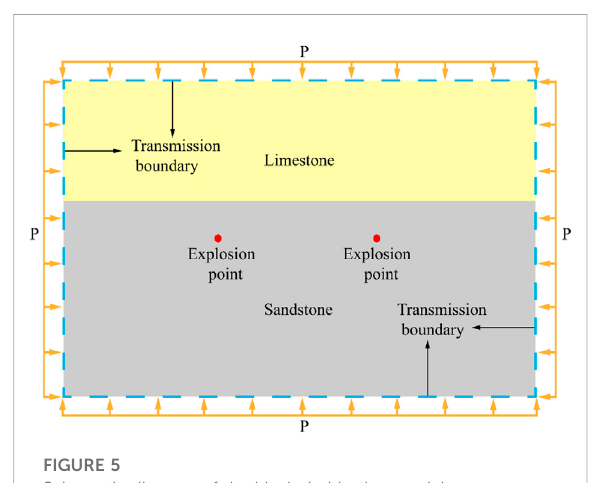
FIGURE 5 Schematic diagram of double-hole blasting